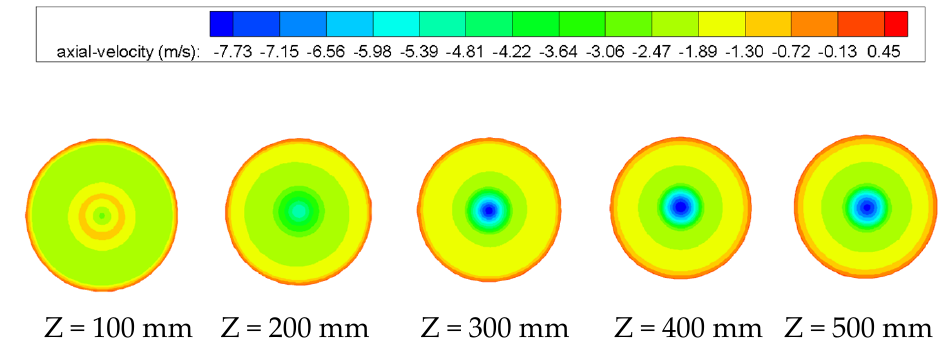
Figure 12. Separator inner cylinder axial velocity distribution at different locations .